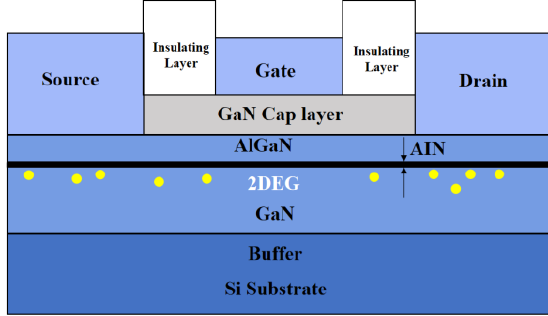
Figure 18. Structure for a Classic GaN HEMT.